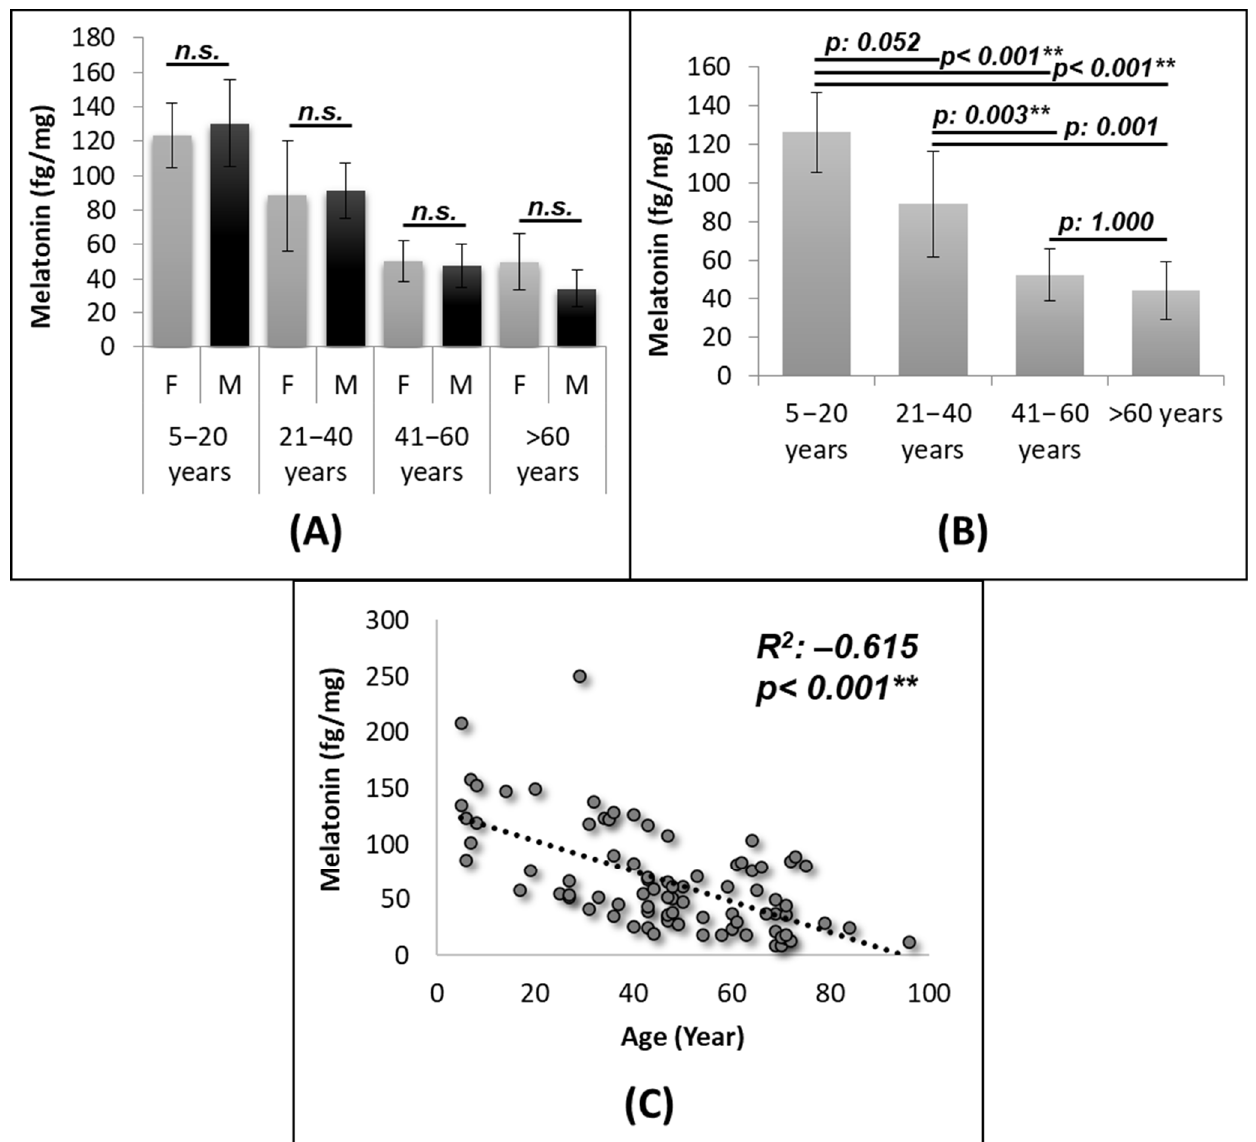
Figure 2. Fingernail melatonin concentrations are able to determine the gradual decrease of melatonin production over the life-span. ( A ) Gender stratified differences in the established age ranges: range 5–20, females ( n = 6) and males ( n = 5); range 21–40, females ( n = 11) and males ( n = 5); range 41–60, females ( n = 14) and males ( n = 15); range > 60, females ( n = 19) and males ( n = 9). ( B ) Differences in age ranges when considering both genders together: range 5–20 ( n = 11); range 21–40 ( n = 16); range 41–60 ( n = 29); range > 60 ( n = 28). ( C ) Correlation between fingernail melatonin concentrations and age. ** Statistically significant differences ( p < 0.01).